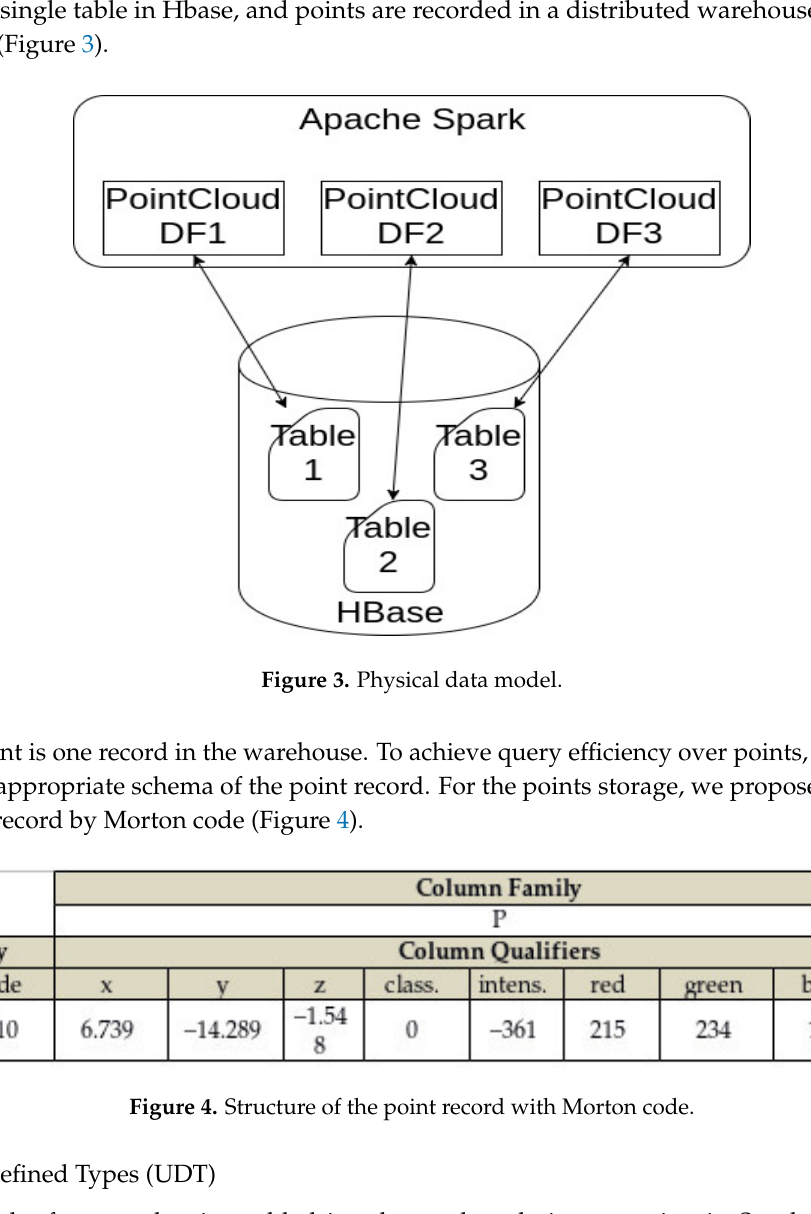
Figure 5. User define function ( UDF) over class point.